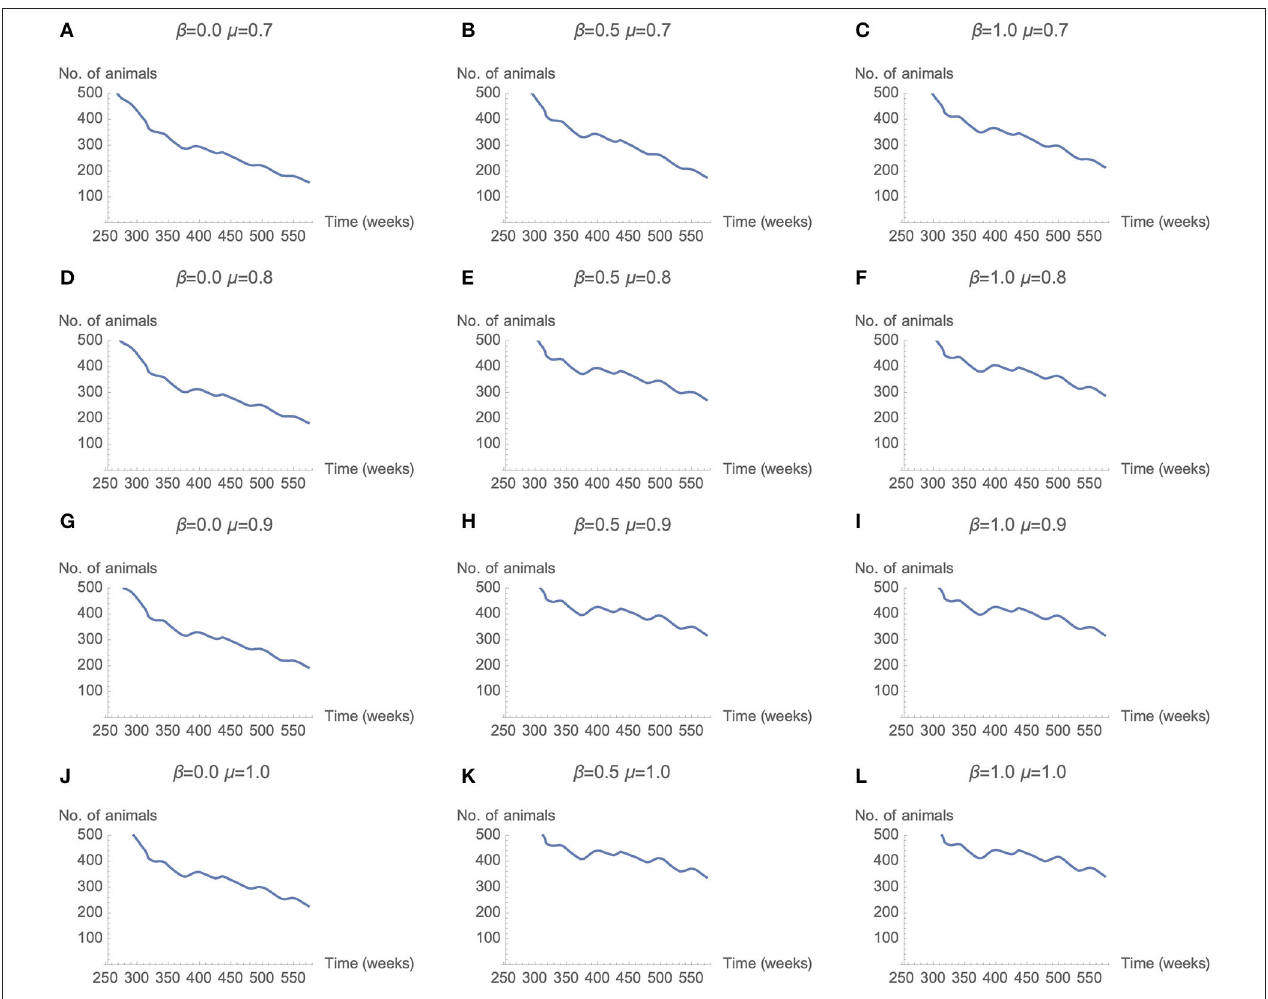
FIGURE 6 | Total herd population over time as µ and β parameters change (50 seeds used per parameter